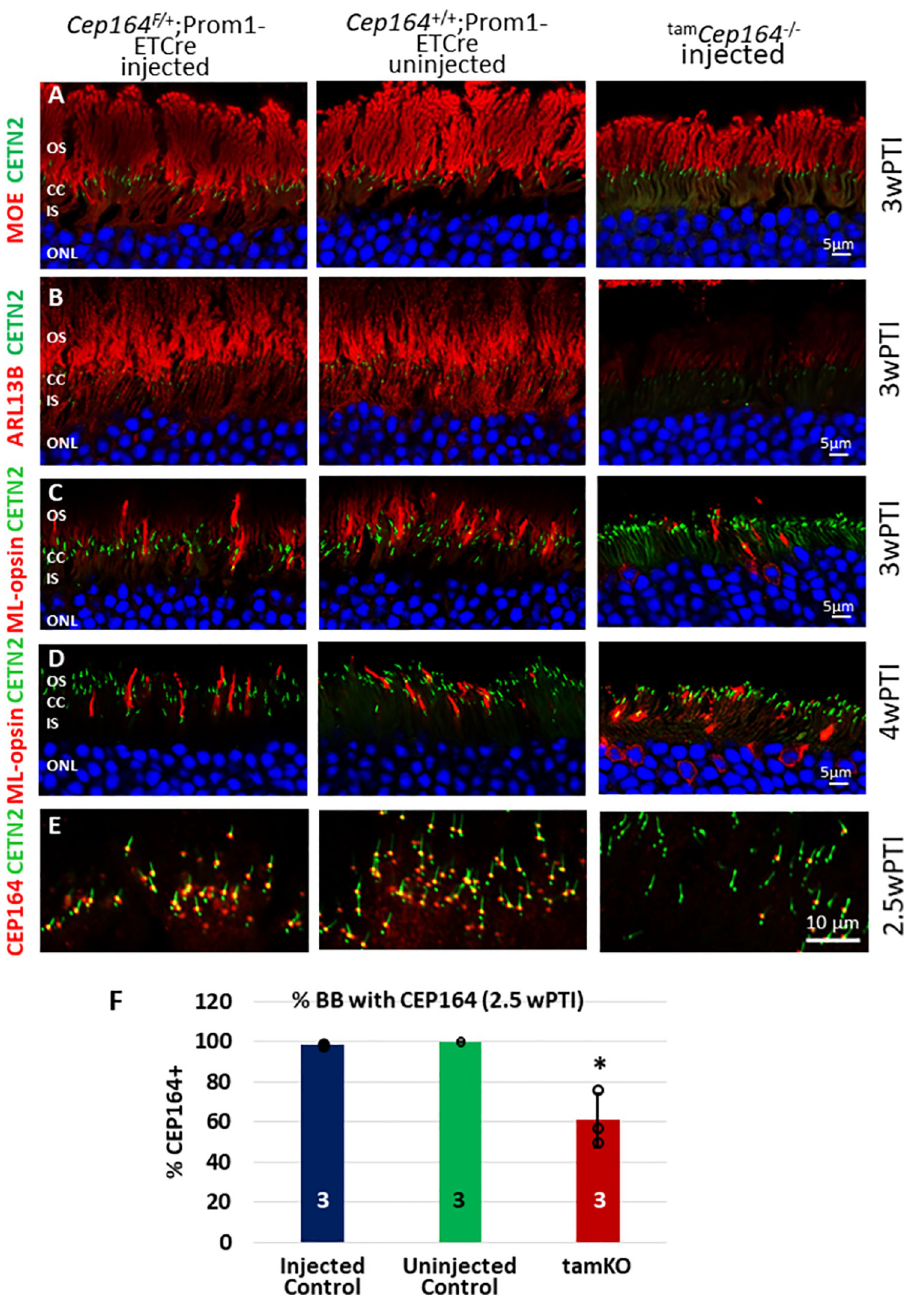
Fig 9. Tamoxifen-induced deletion of CEP164 in adult mouse. Row A , Cep164 +/F ;Prom1-ETCre (injected) (left panel), Cep164 +/+ ;Prom1-ETCre (uninjected) (middle panel) and Cep164 F /F ;Prom1-ETCre ( tam Cep164 -/- ) (injected) (right panels) on EGFP-CETN2 background probed with anti-CEP164. Note near even distribution BB/CCs with and without CEP164 in the knockout panel. Rows B-E , immunohistochemistry of injected control cryosections (left panels), of uninjected Prom1-ETCre cryosections (middle panels) and of tam Cep164 -/- (right panels) probed with MOE (anti-PDE6) (A), anti-ARL13B (B), or ML-opsin antibody (C, D). Row A is at 2.5wPTI. Rows B-D are at 3wPTI, and row E at 4wPTI. F , BB of injected controls (no Cre), injected heterozygotes (with Cre), uninjected control and tam Cep164 -/- retina assayed for presence of CEP164 immunoreactivity. Essentially all control BB displayed CEP164; in tam Cep164 -/- retina, about 40% of BB did not. tam CEP164 -/- is P < 0.05 compared to both controls. Numbers in columns refer to animal numbers (n = 3